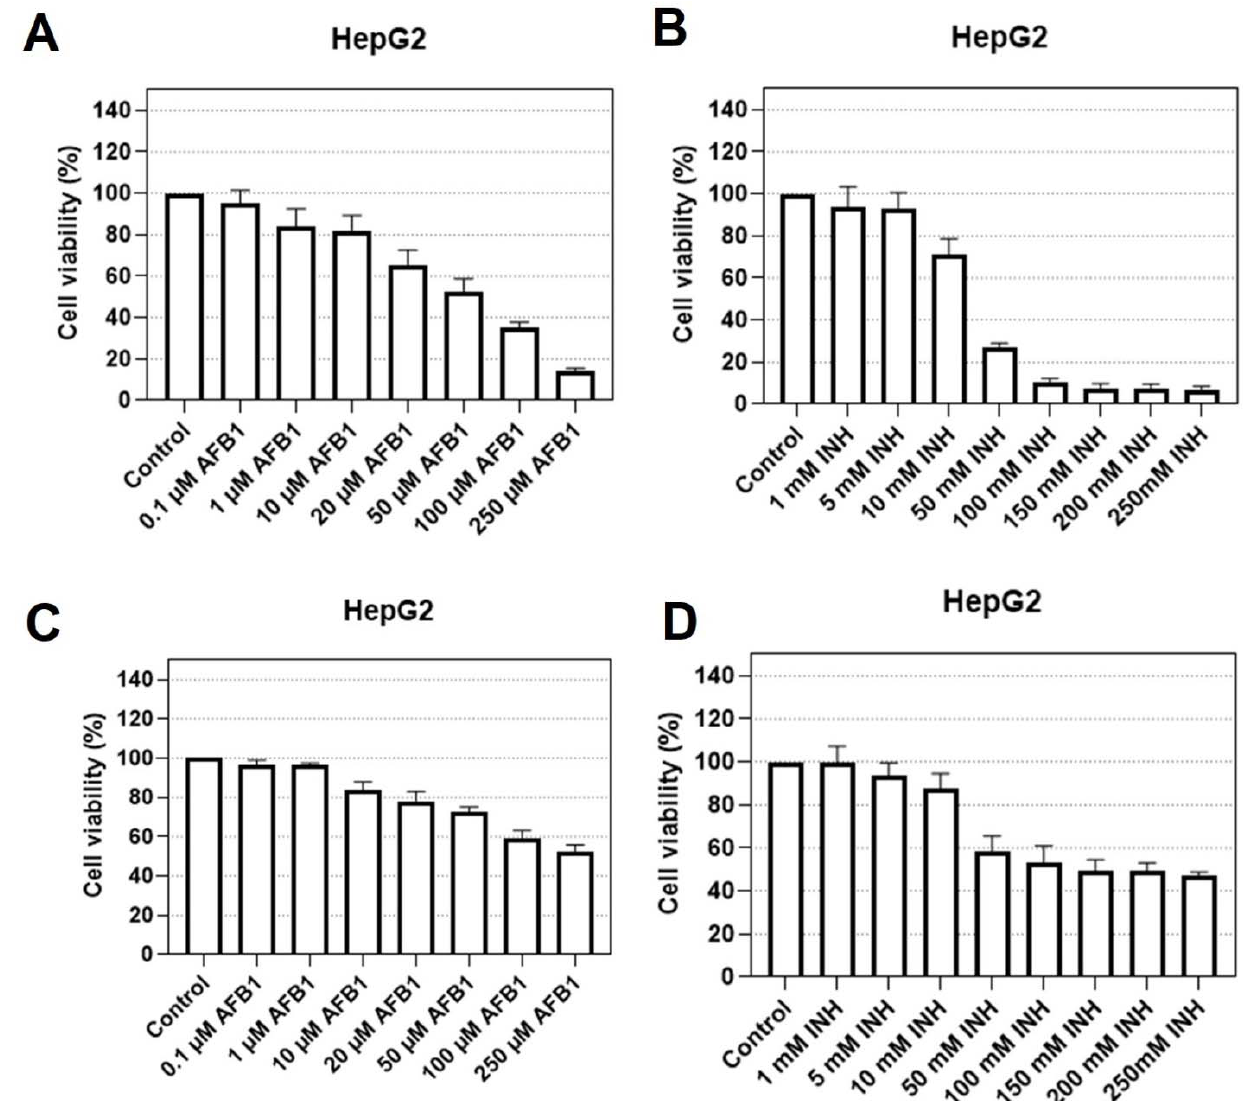
Figure 1. The HepG2 cell viability after exposure to various concentrations of AFB1 ( A ) and INH ( B ) when stained with neutral red and cell viability following the Coomassie Brilliant Blue staining test for AFB1 ( C ) and INH ( D ). The results are given as mean values of the three measurements ± STD (p < 0.001).